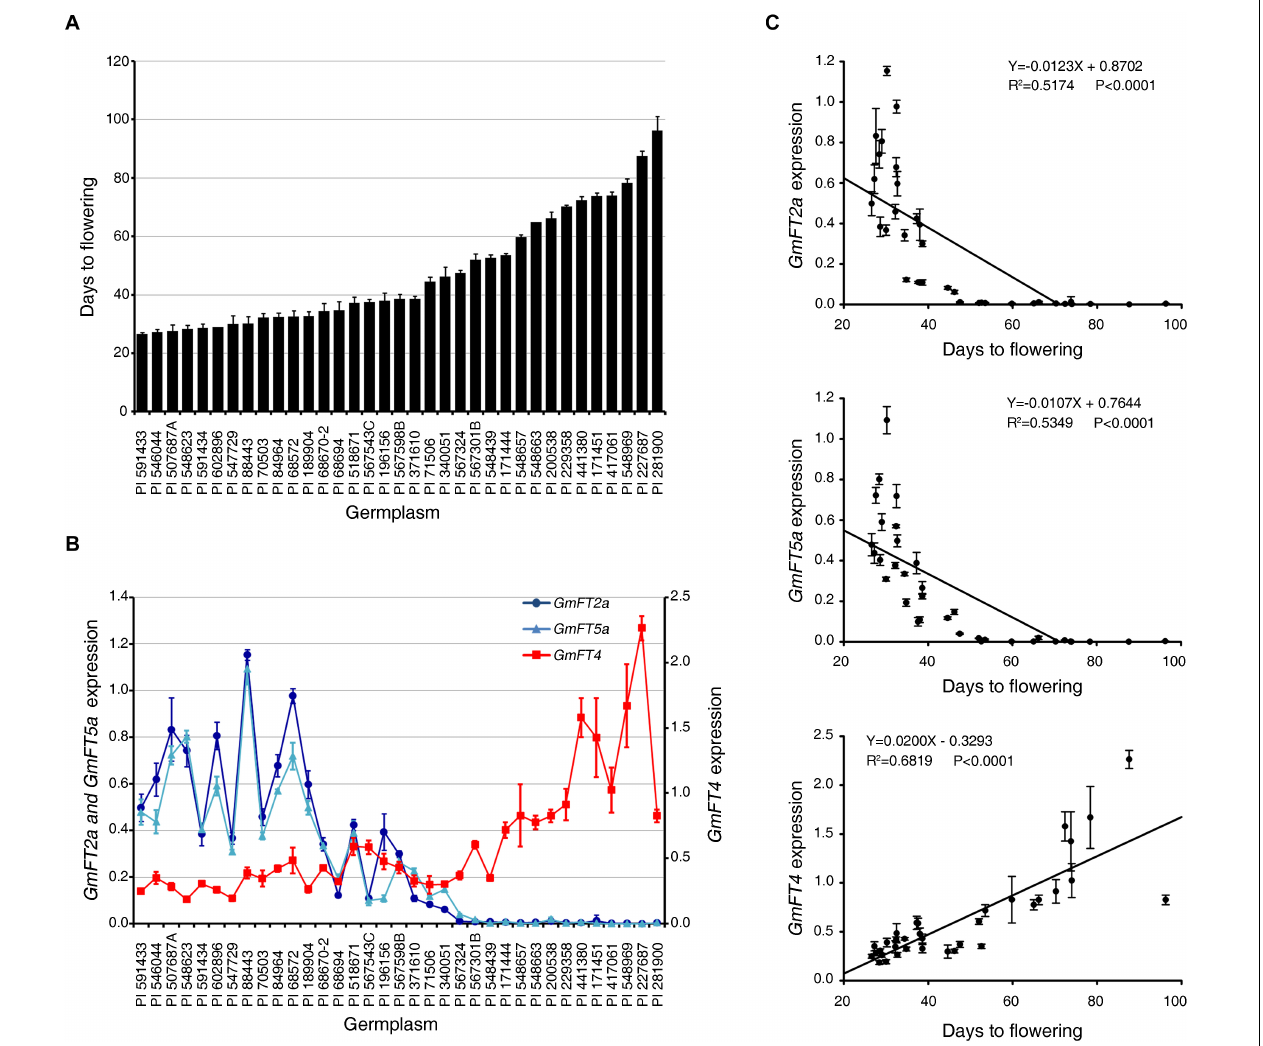
FIGURE 7 | Expression of GmFT2a , GmFT5a , and GmFT4 genes in soybean accessions. (A) The number of days to flowering of 35 USDA soybean accessions grown in field conditions. (B) Evaluation of transcript levels of GmFT2a , GmFT5a , and GmFT4 in the third trifoliate (V3) leaves of 30-day old (V4 stage) plants by qRT-PCR with three independent biological replicates. Transcript levels were normalized to GmPBB2 mRNA levels. (C) Correlation analysis between expression levels of GmFT2a , GmFT5a , and GmFT4 mRNAs and flowering times of USDA soybean accessions. Data are shown as means ± standard